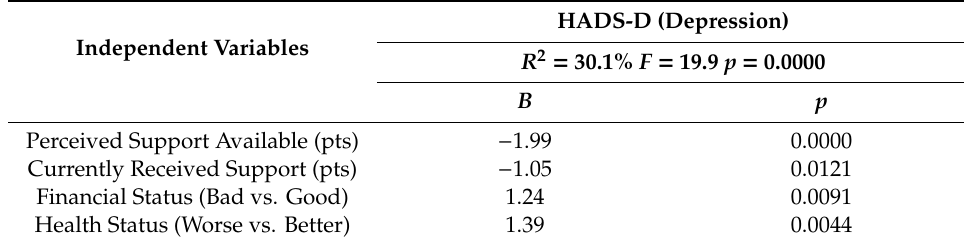
Table 7. Regression model for predicting HADS-D only in the study